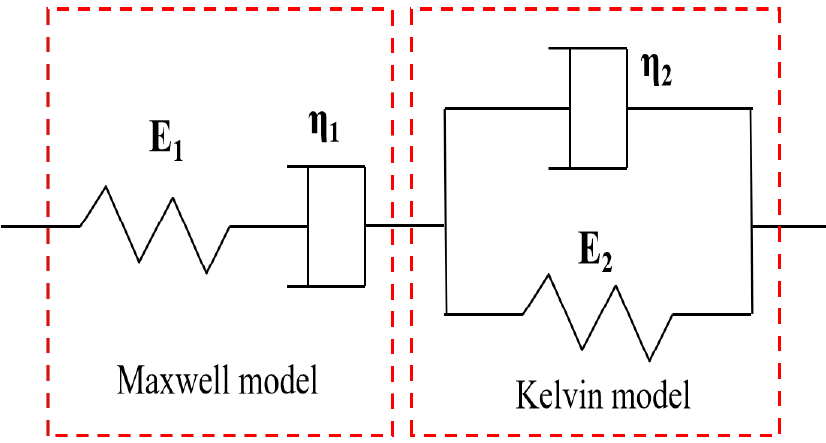
Figure 10. Schematic of the Burgers model with dashpot and spring components.